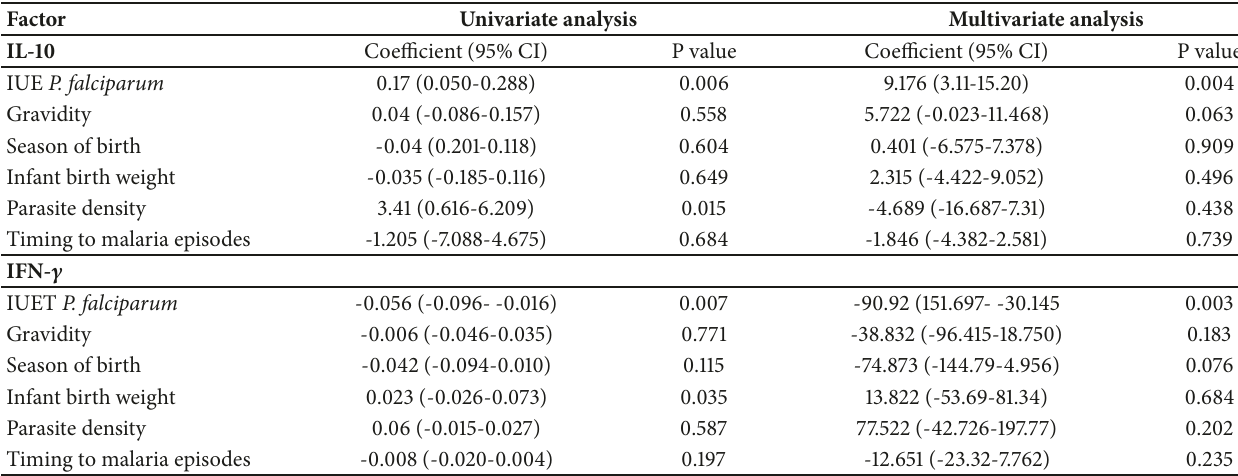
Table 3: Effect of prenatal exposure to P. falciparum , gravidity, season of birth, parasite density, timing of malaria episodes, and birth weight on IL-10 and IFN- 𝛾 responses during clinical malaria episodes: Multiple linear regression model